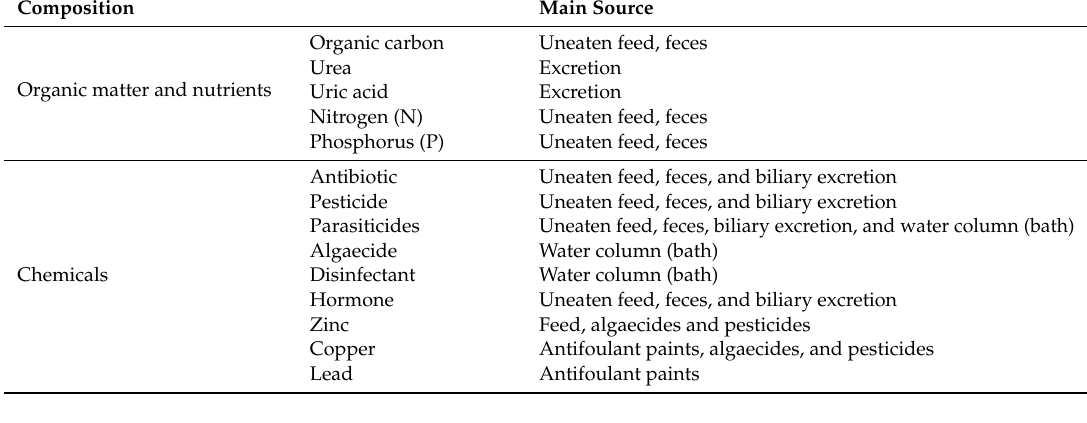
Table 1. List of composition and main source of mariculture e ffl uent in cage system.